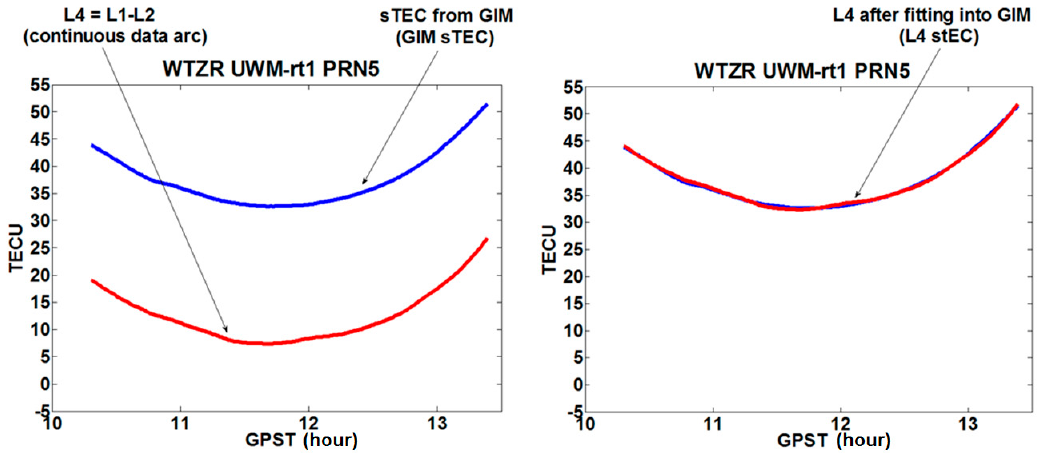
Figure 3. Scheme of the L4 data fitting into Global Ionosphere Maps’ (GIM) slant TEC (sTEC) (sTEC calibration).